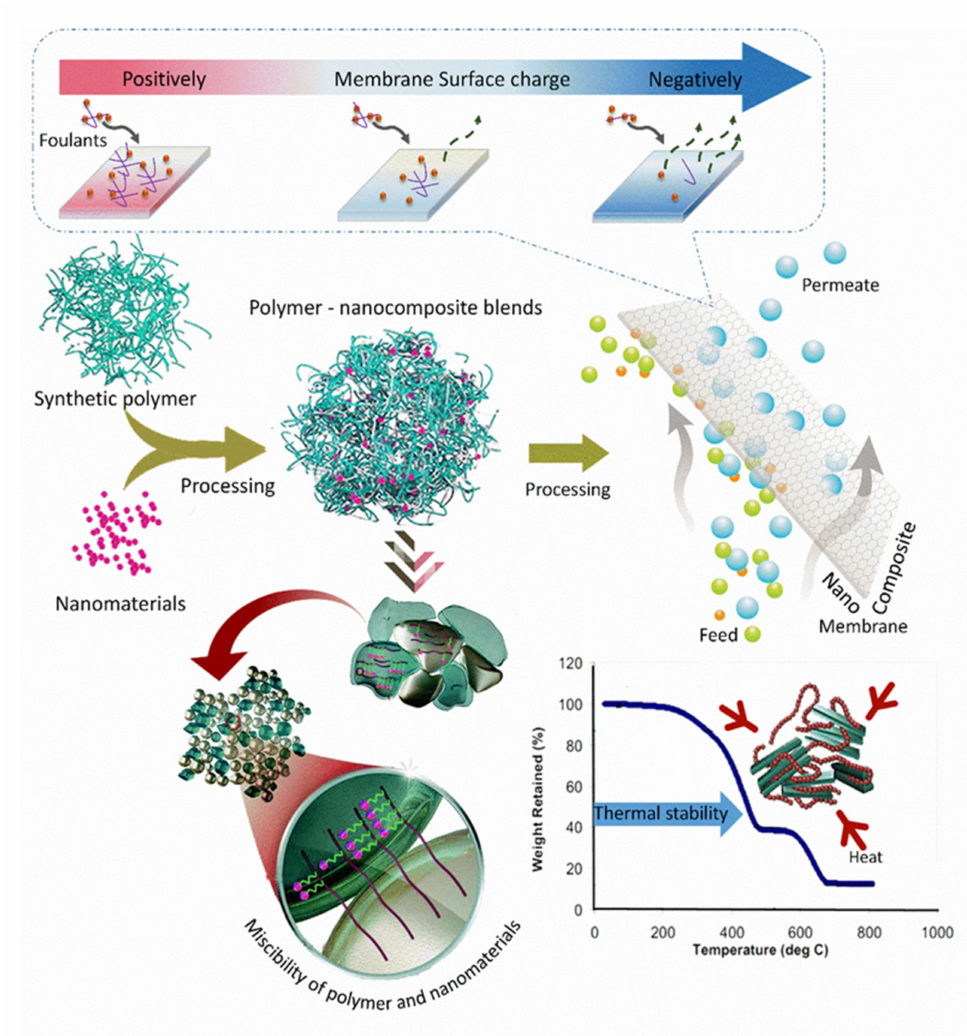
Figure 9. Illustration of the preparation of a PPSU nanocomposite membrane with higher surface and thermomechanical properties via a typical polymer and nanomaterial blend